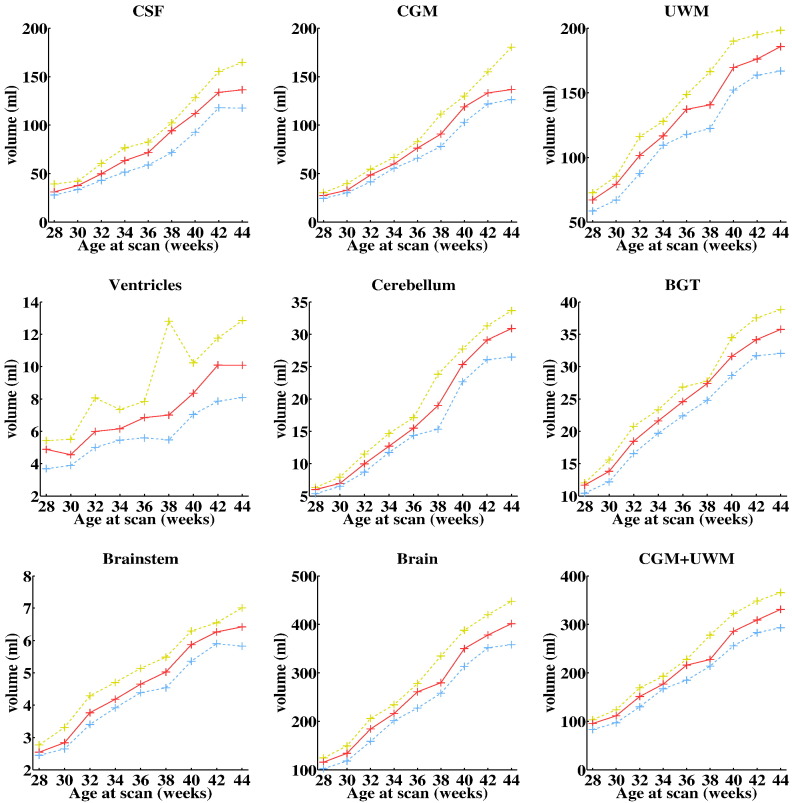
Volume(mL) centiles of tissues with increasing scan age. The yellow line for each region represents the 25% centile over the subjects in the database, the red line the median value, and the blue line the 75% centile.